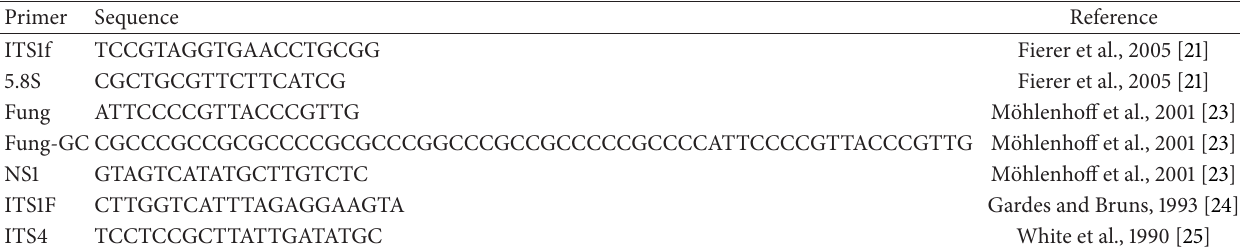
Table 1: Sequences of the primer sets used.